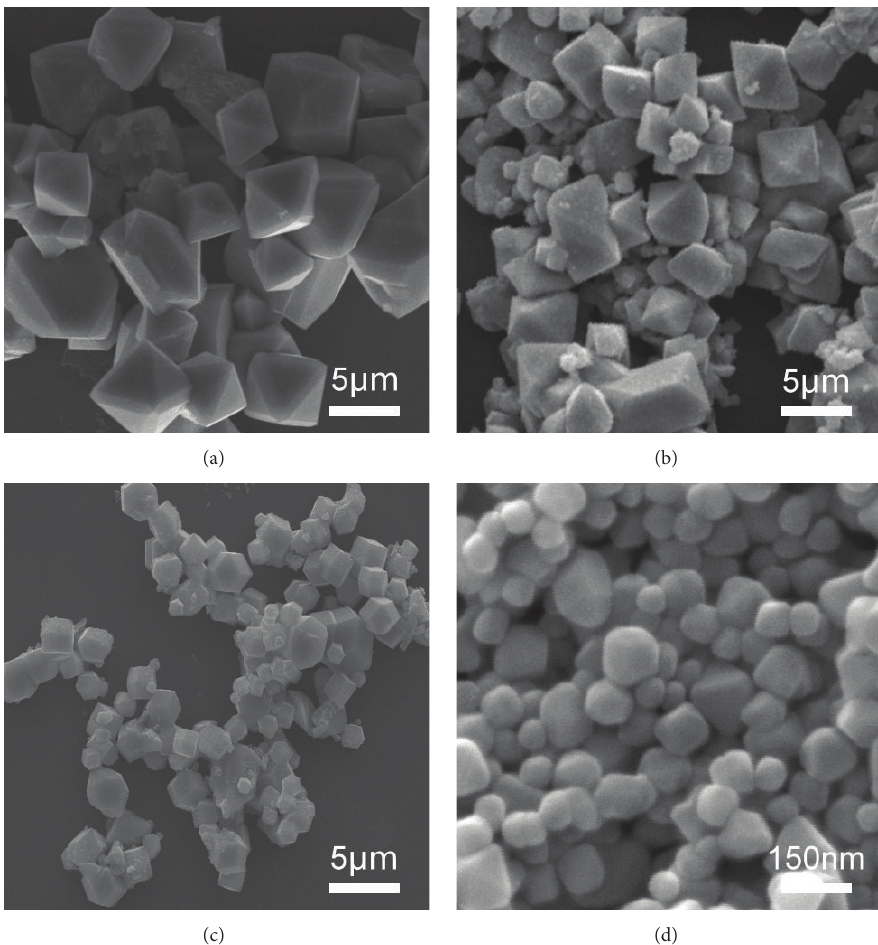
Figure 3: SEM images of samples obtained using different amounts of NaOH: (a) 2.0 mmol (pH = 7), (b) 3.75 mmol (pH = 8), (c) 5.0 mmol (pH = 9), and (d) 12.5 mmol (pH >